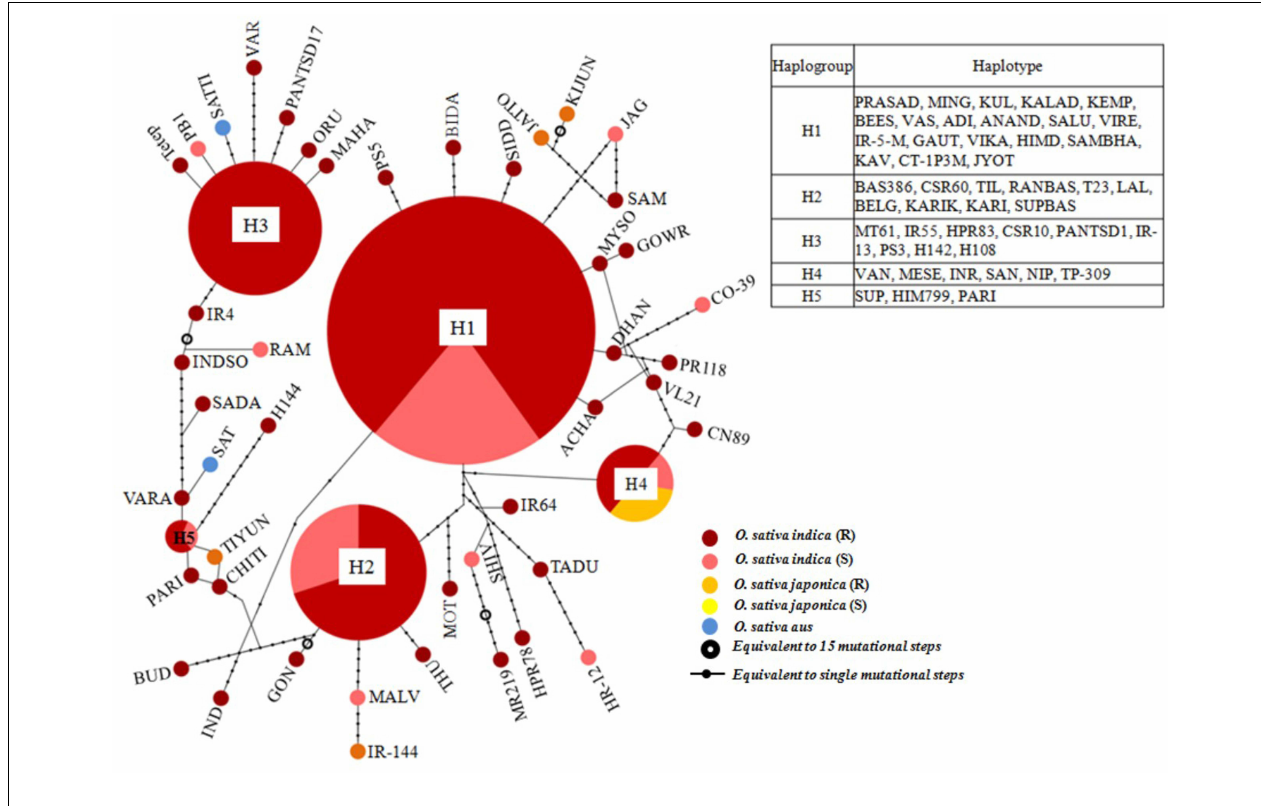
FIGURE 5 | A haplotype network based on potential SNPs of the 92 Pi54 alleles. Each group of haplotypes is shown as a solid circle, and five major haplotypes are marked in larger circles. Each branch represents a